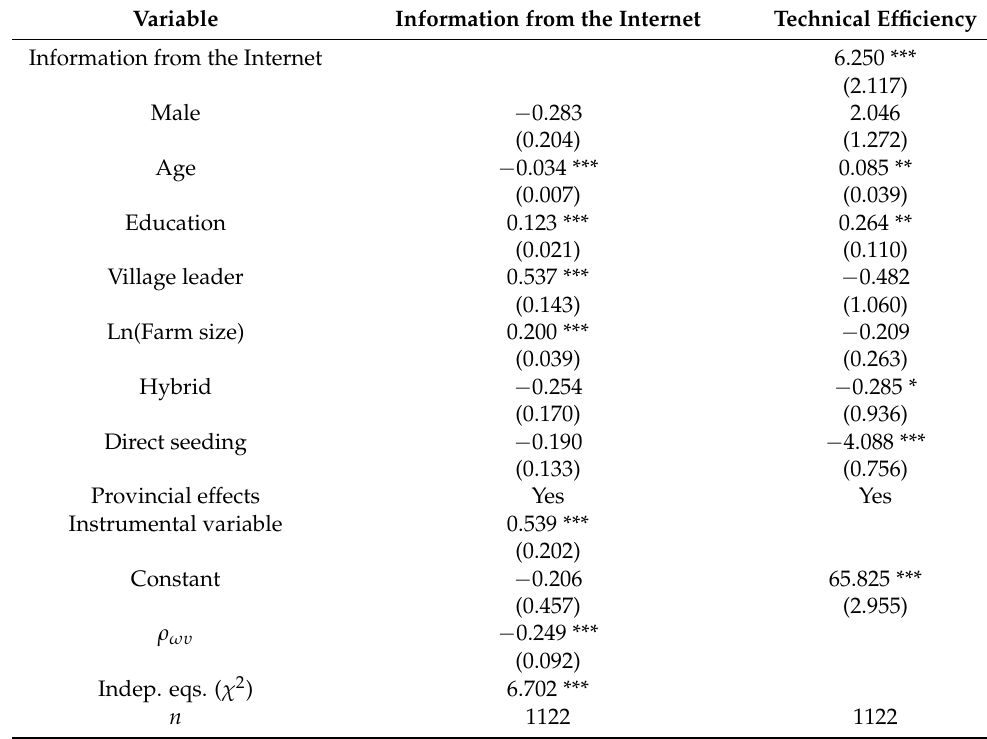
Table 8. Estimation results of the treatment-effect